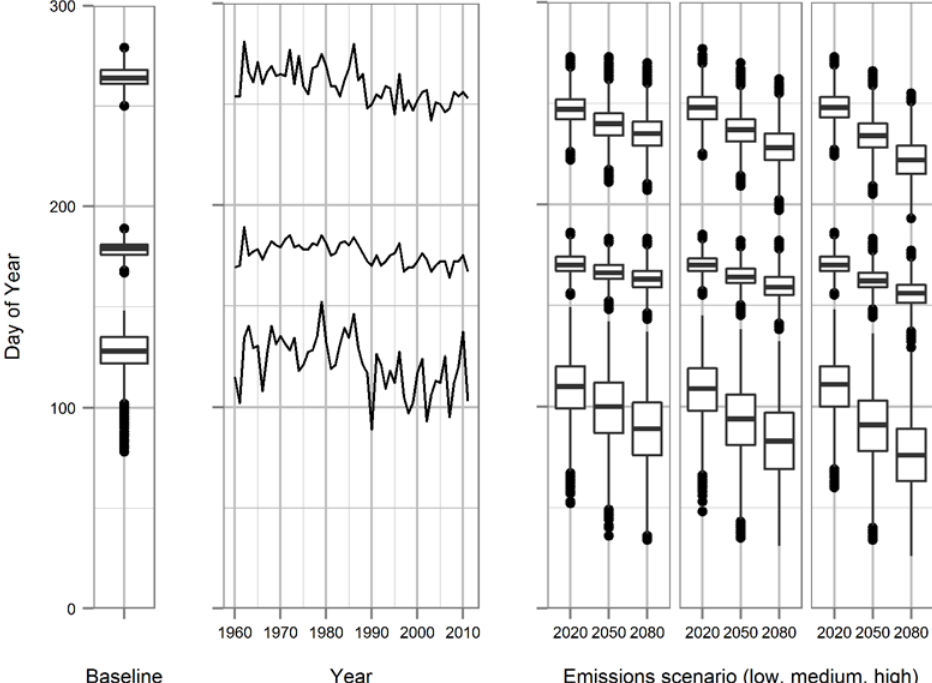
Fig 3. Modelled times of budbreak, flowering and veraison (from bottom to top) calculated from baseline (1960 – 90) weather generator runs, daily observed weather (1960 – 2011) and future climate weather generator runs using three emissions scenarios (low, middle and high emissions from left to right) and time periods.